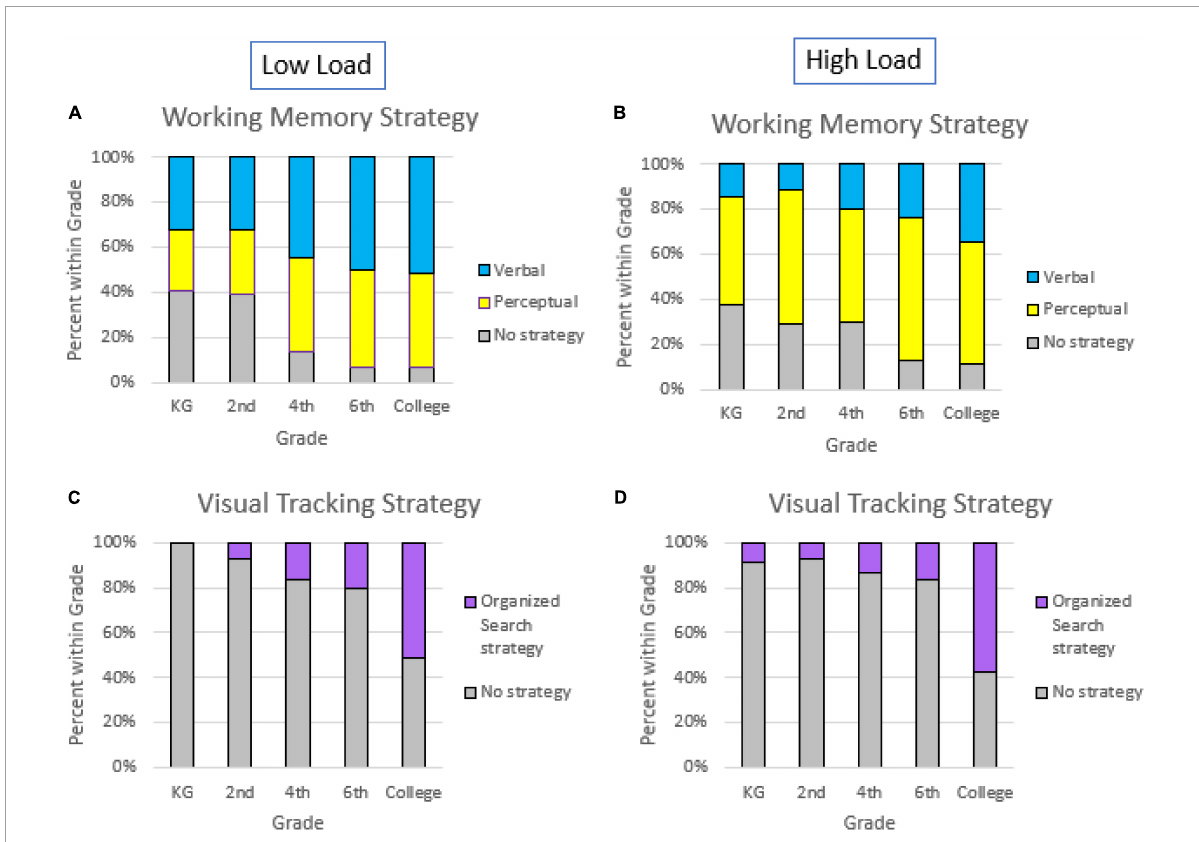
FIGURE7 Percentage of participants who used working memory strategies to encode the target by grade in low-load (A) and high-load sessions (B) , and percentage of participants who used visual tracking strategies during the visual search by grade in low-load (C) and high-load (D)